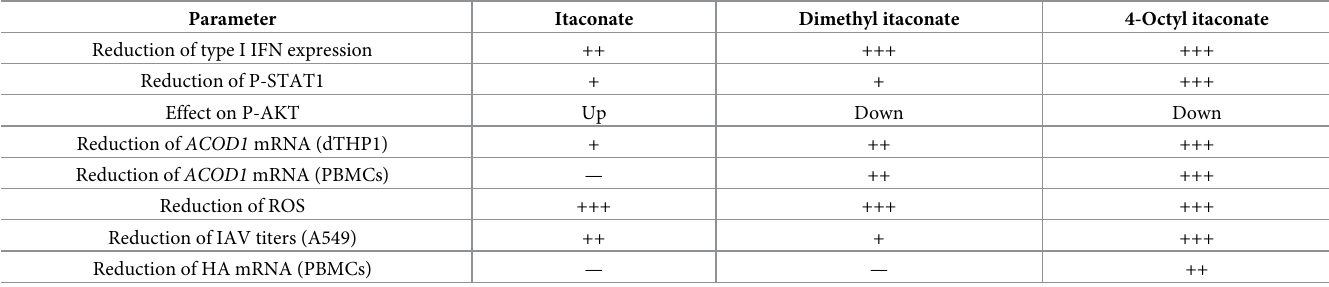
Table 1. Comparison of key features of the three